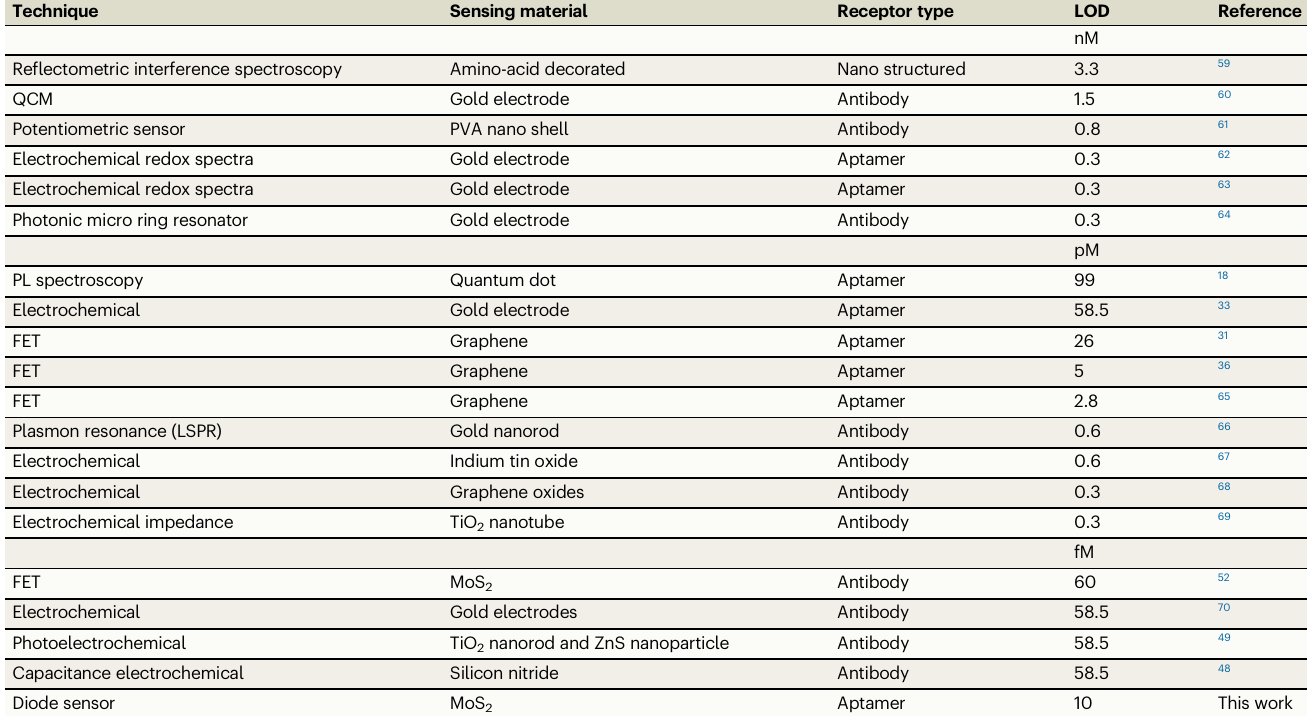
Table 1 | Comparison of biosensors for the detection of TNF- α , listing the technique, the sensing material, receptor type used, and the reported limit of detection (LOD)